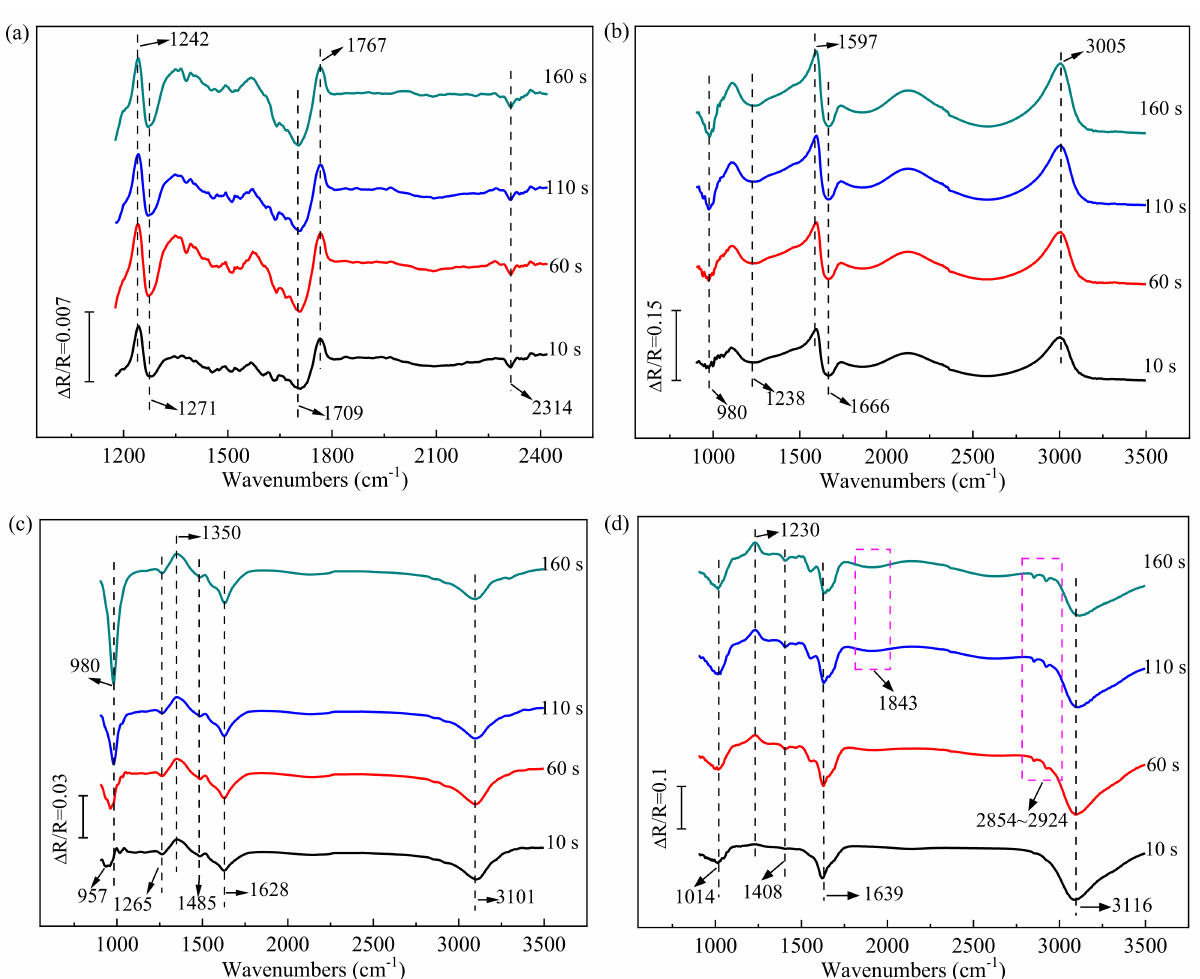
Figure 2. In − situ FTIR spectra collected in electrolysis of COD ( a ), NH 4+ ( b ), NO 3 − ( c ), and NO 2 − ( d ) solution with electrolysis